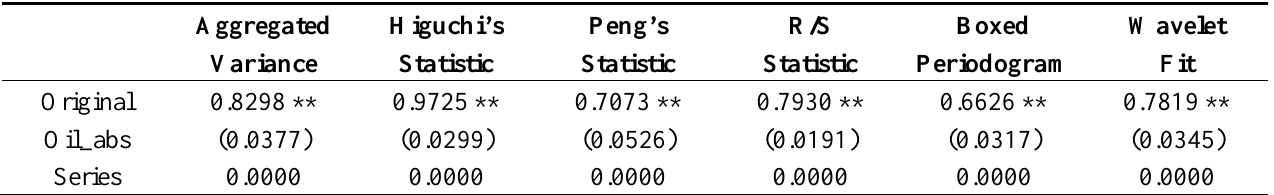
Table 3. Scaling exponent H test results of oil return volatilities (full